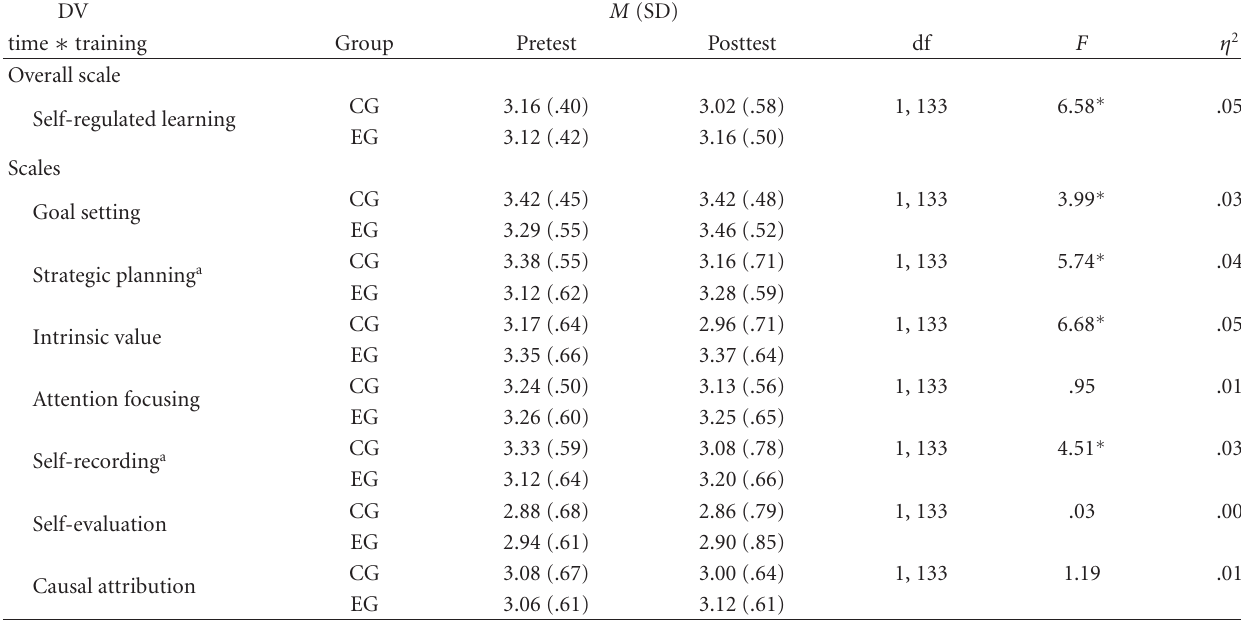
Table 5: Descriptive data of the self-regulated learning variables and results for the interaction time × training. DV M